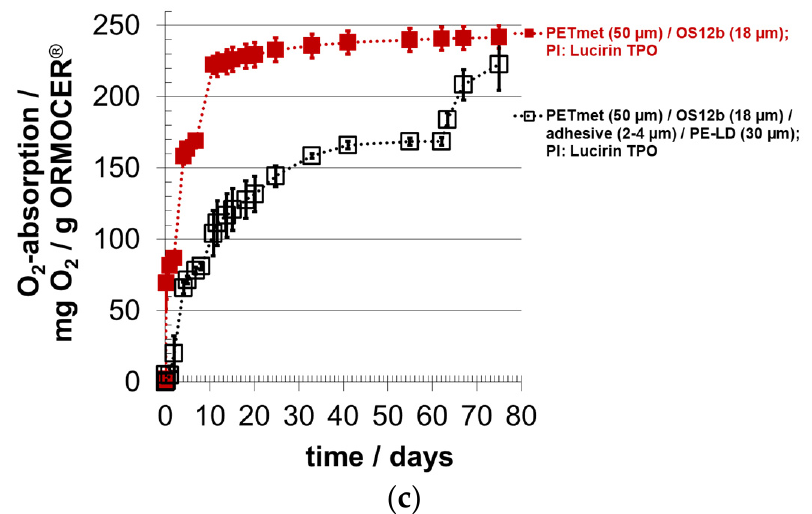
Figure 7. Oxygen absorption of oxygen scavenger ‘ORMOCER ® OS12b’ with photo-initiator (PI) Lucirin TPO; curing time: 10 min; OS coating thickness (dry) around 18.2 ± 3.5 µm (corresponds to 17.1 ± 3.3 g/m 2 ); with and without sealing layer PE-LD; ( a , b ) course of the oxygen concentration, ( c ) course of the oxygen absorption.